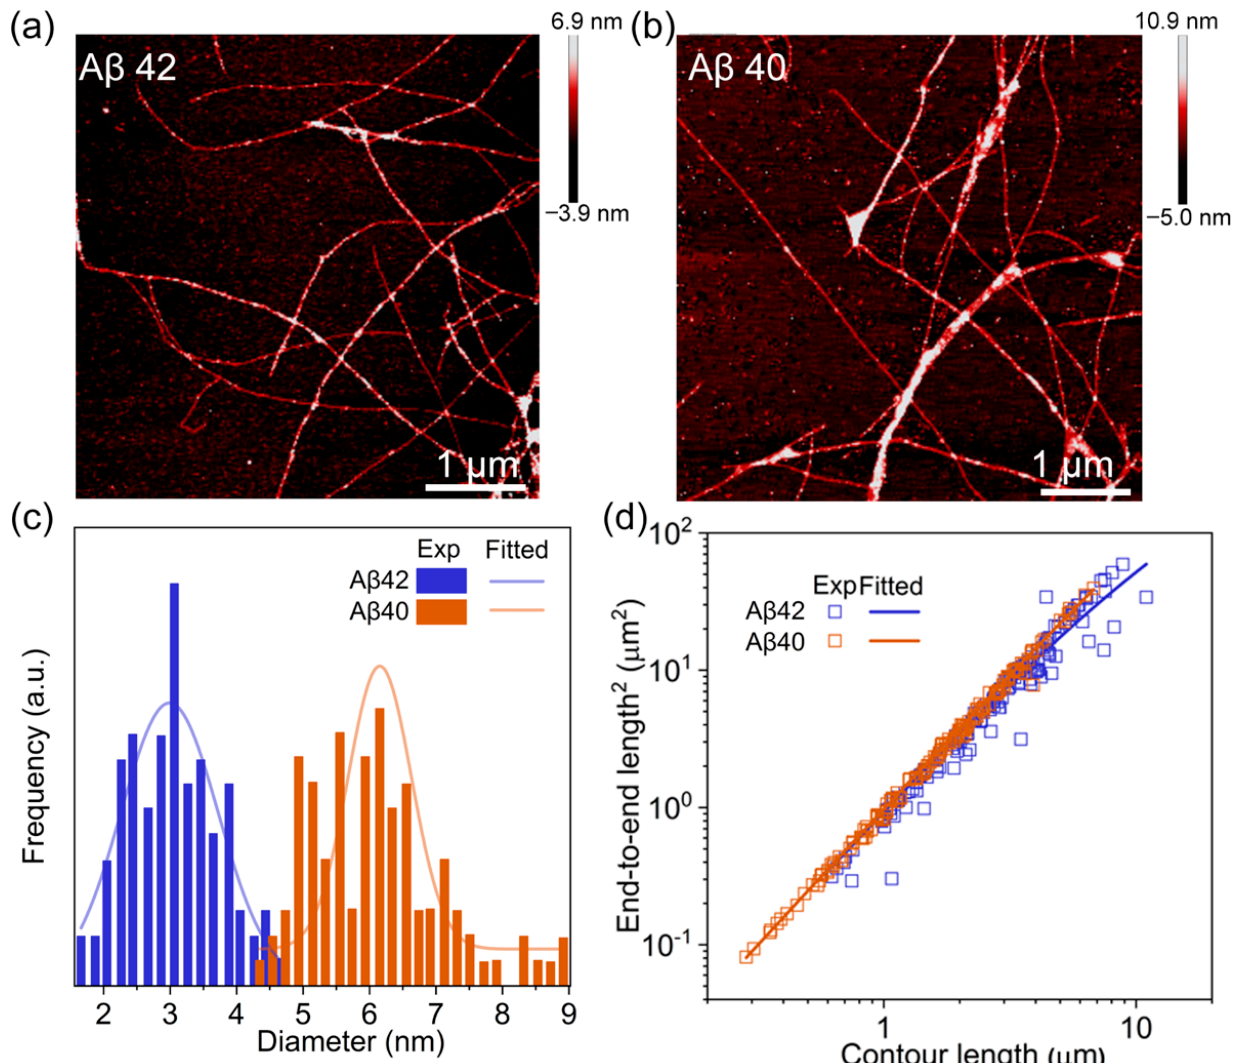
Figure 4. AFM-based microstructure analysis of the formed fibrils. ( a ) AFM image of A β 42 fibrils obtained at the post-transition stage, showing that A β 42 monomers are completely transformed into fibrils. ( b ) AFM image of A β 40 fibrils captured at the post-transition stage. ( c ) The diameter distributions of A β 42 and A β 40 fibrils. The blue bar and line denote the experimentally measured data and Gaussian fitting, respectively, for the diameter of A β 42 fibrils, while the brown bar and line represent the experimental data and Gaussian fitting, respectively, for the diameter of A β 40 fibrils. ( d ) The relationship between contour length and end-to-end length for A β 42 and A β 40 fibrils, respectively, indicated as blue and brown